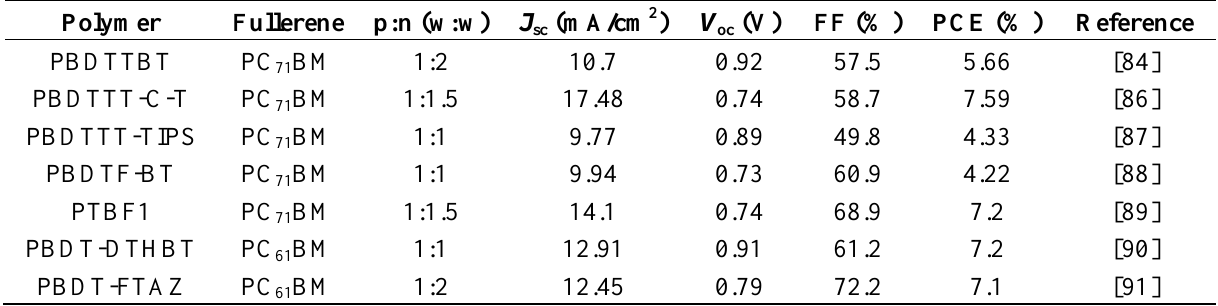
Table 1. BDT-based 2D conjugated polymers for